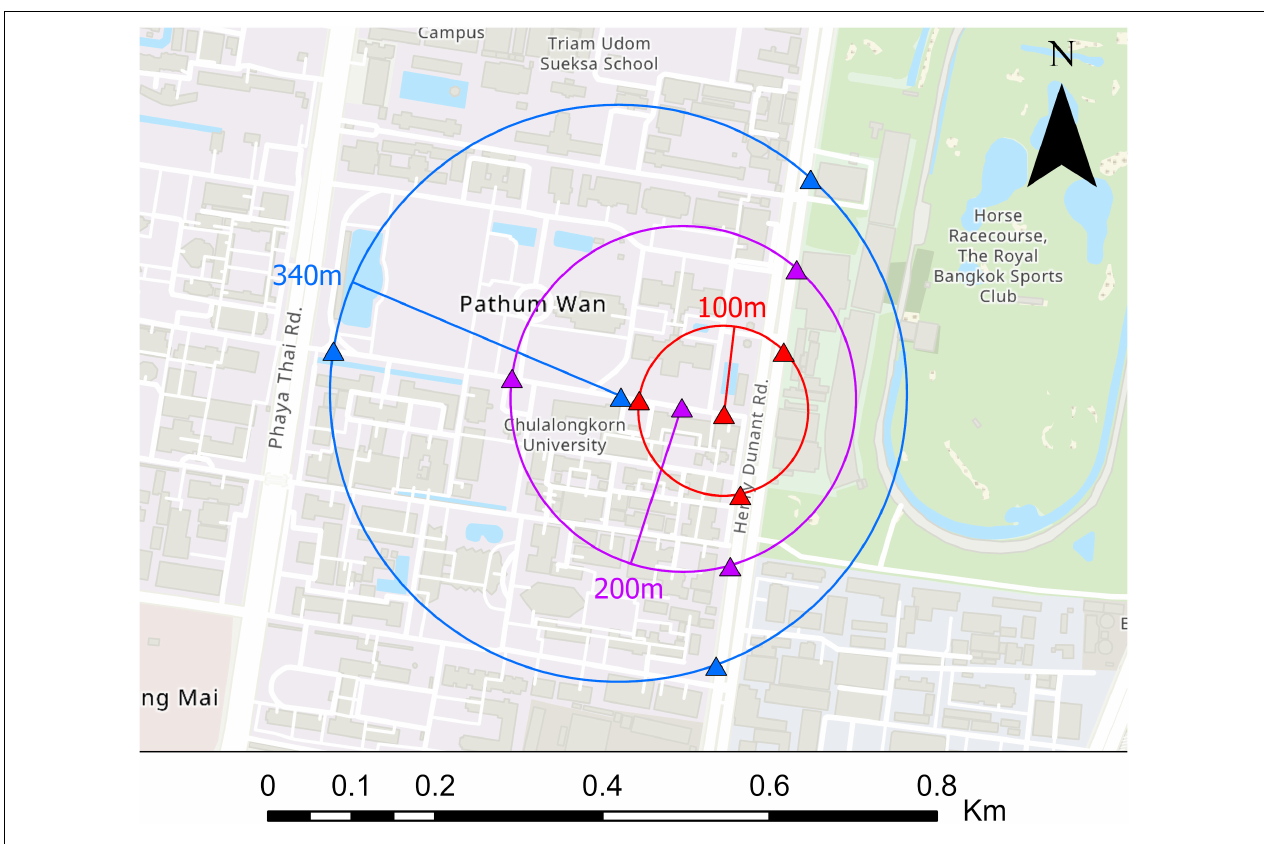
FIGURE 4 | The geometry of the JU410 arrays at site CU; triangles represent the JU410 sensors.